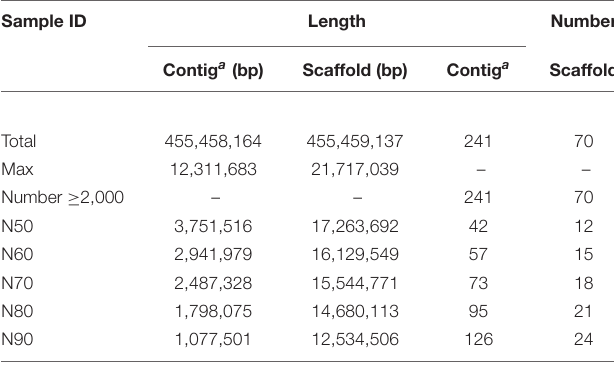
TABLE 2 | Statistics of the B. mori genome